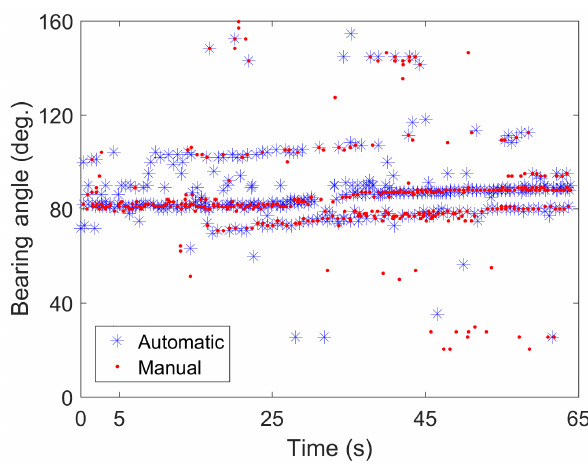
Figure 15. Estimated bearing angles from automatic (blue stars) and manual (red dots) detections made just after the beginning of file